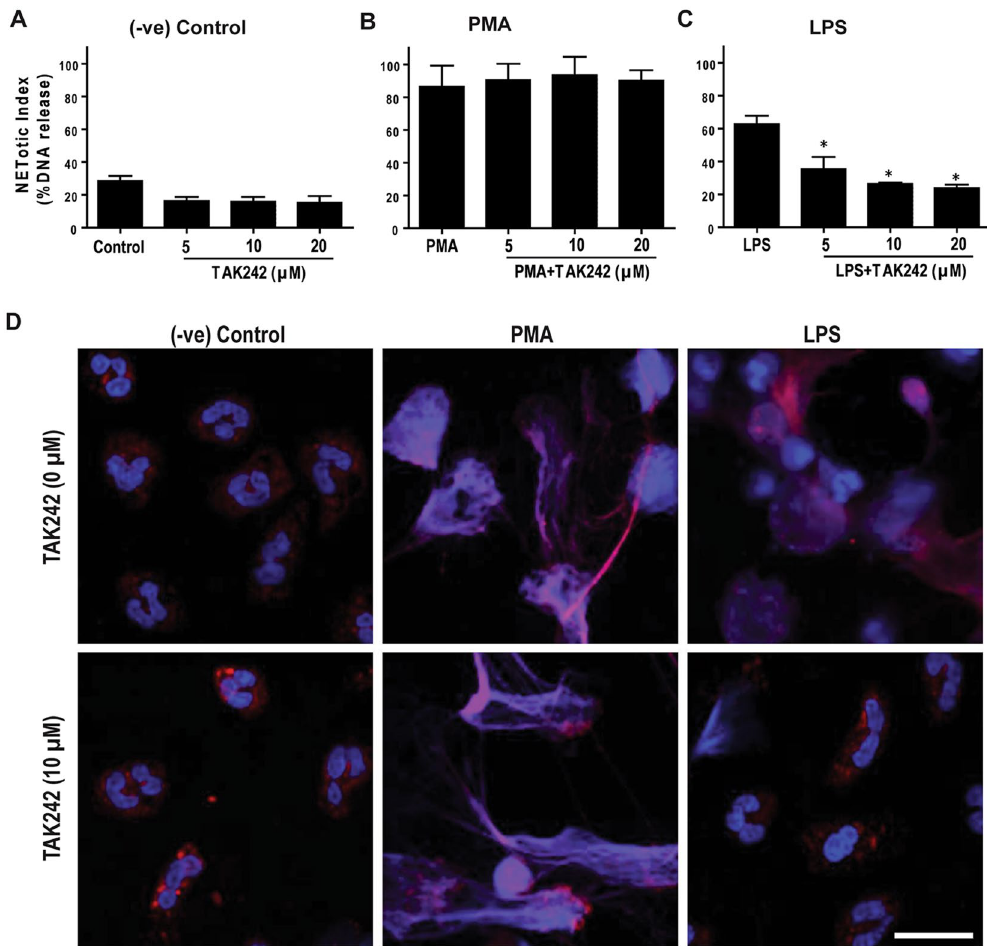
Figure 6. TLR4 signaling inhibition by TAK242 suppresses LPS-mediated NETosis . ( A–C ) NETosis kinetics was assessed by Sytox Green plate reader assay after activation with 25 nM PMA and 25 μ g/ml LPS in the presence or absence of TAK242. As shown in the %DNA release analysis, TAK242 (5, 10, 20 μ M) suppresses LPS mediated NETosis, while not in PMA mediated NETosis (n = 3–4; * p value < 0.05; One-way ANOVA with Tukey’s multiple comparison post test). Error bars in all the panels represent SEM. ( D ) Neutrophils were activated by PMA and LPS with and without TAK242 for 4 hours, immunostained, and imaged for myeloperoxidase (MPO) and DNA. MPO is visible around the nuclei in media control with or without TAK242. MPO co-localizes to NET DNA generated by LPS, PMA, and PMA with TAK242. Treating neutrophils with LPS in the presence of TAK242 does not results in NETosis, and the nuclear morphology of these cells remains the same as that of the unstimulated control neutrophils (Blue, DAPI staining for DNA; Red, MPO; n = 3; scale bar 20 μ m). See Supplementary Fig. S6 for low magnification